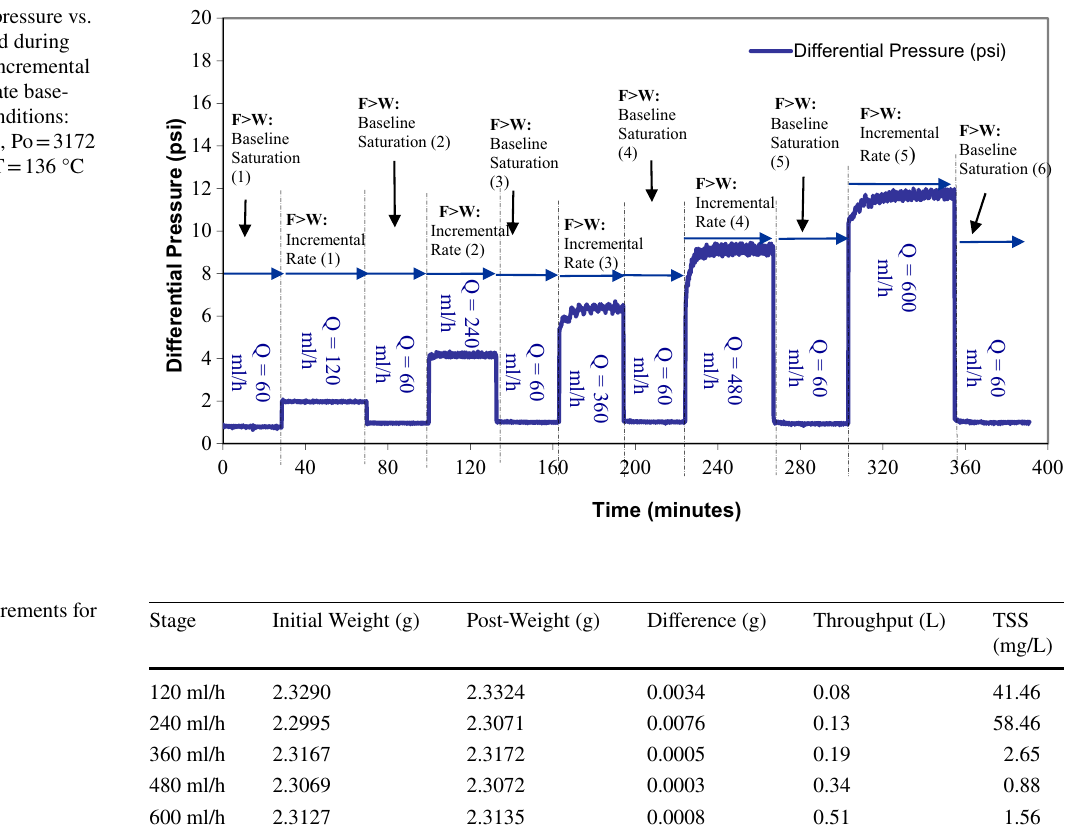
Fig. 7 Differential pressure vs. time profile recorded during brine saturation at incremental rates and intermediate base- line saturations. Conditions: